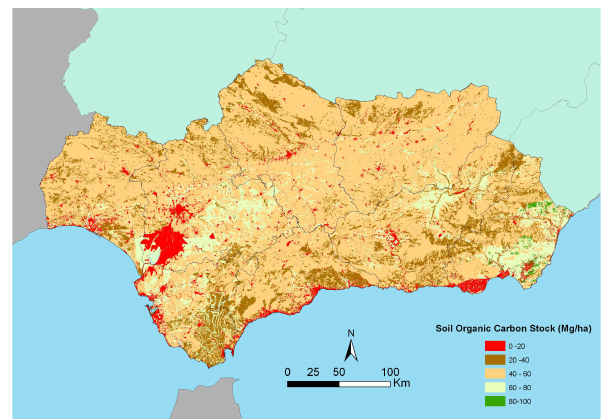
Fig. 6. Map of soil organic carbon content (0–75cm) in